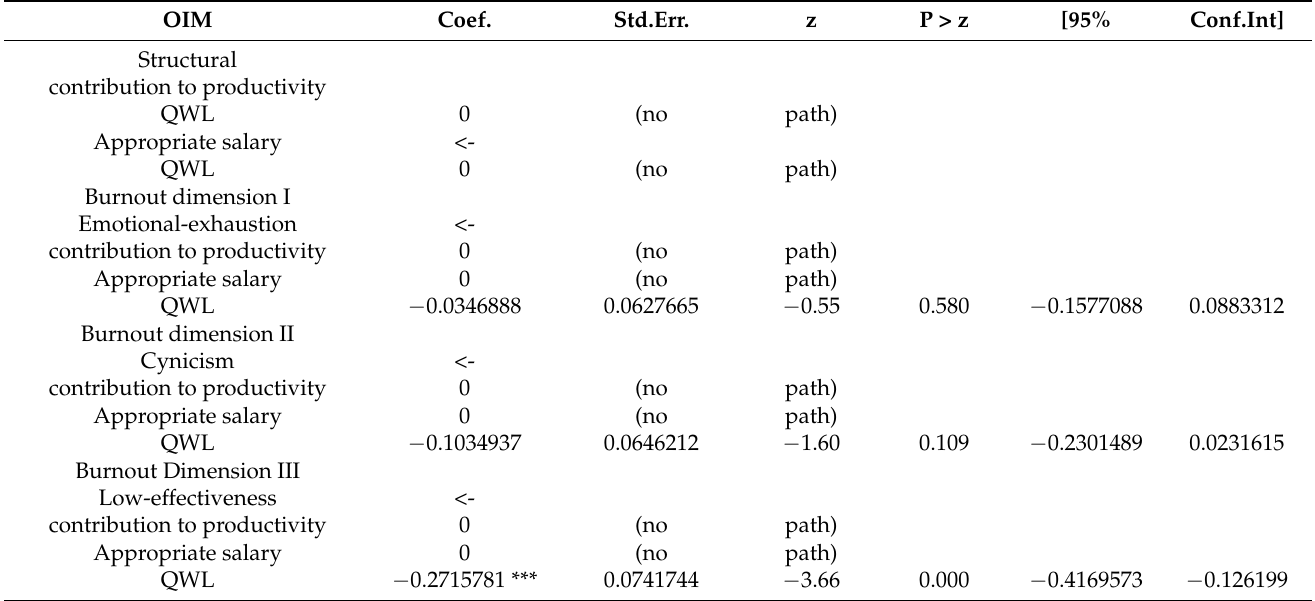
Table 7. Model 2: Indirect